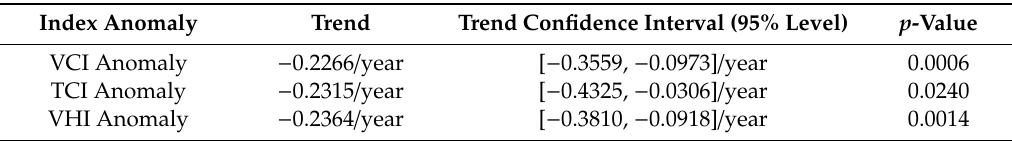
Table 2. Statistics of Vegetation Condition Index (VCI), Temperature Condition Index (TCI), and VHI anomaly trends of HOA cropland from the years 2001 to 2017.